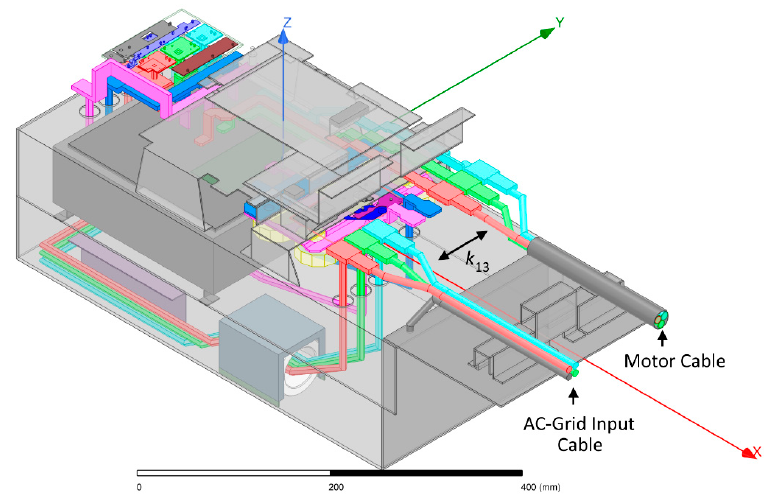
Figure 3. 3D model of the chassis and busbar geometry in the prototype for parasitic RLGC extraction (MoM) [141].